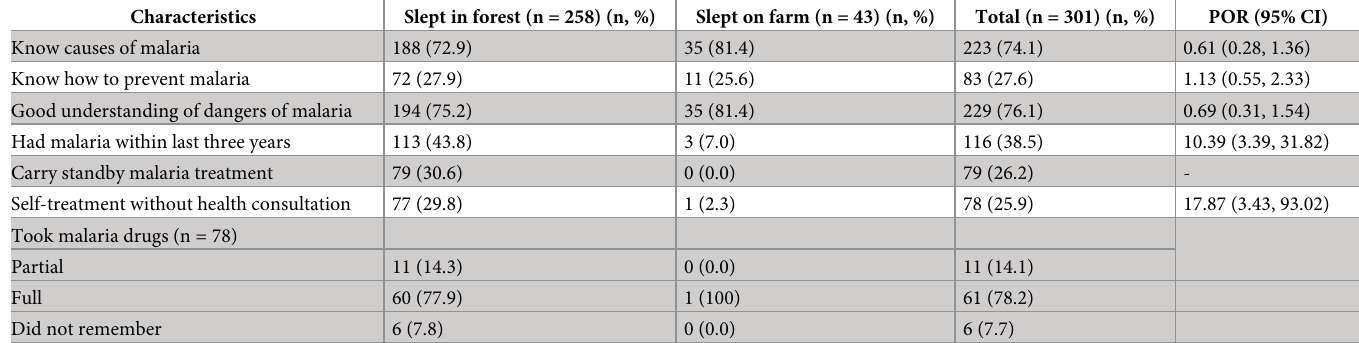
Table 5. Malaria prevention knowledge, attitudes and practices among respondents who slept in the forest or on a farm. Characteristics